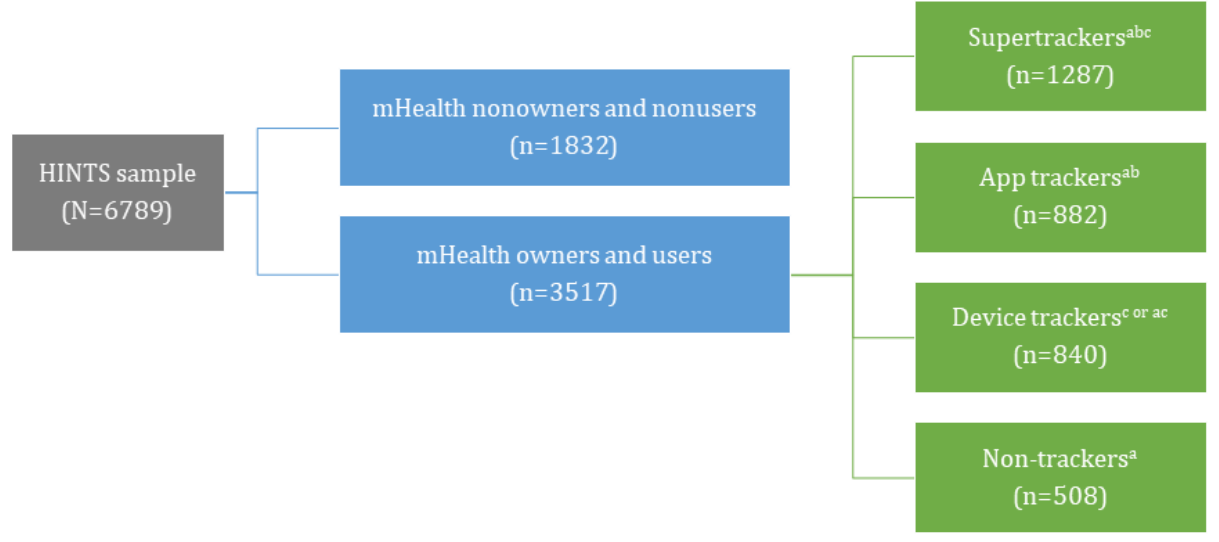
Figure 1. Operationalizing pattern of mobile health use for health and behavioral tracking. a. On your tablet or smartphone, do you have any “apps” related to health and wellness? Yes. b. Has your tablet or smartphone helped you track progress on a health-related goal such as quitting smoking, losing weight, or increasing physical activity? Yes. c. Other than a tablet or smartphone, have you used an electronic device to monitor or track your health within the last 12 months? Examples include Fitbit, blood glucose meters, and blood pressure monitors. Yes. HINTS: Health Information National Trends